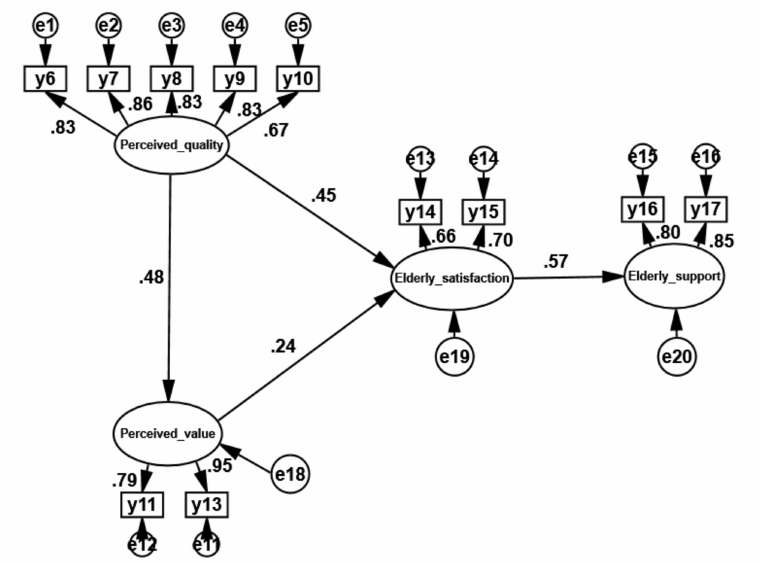
Figure 5. Modified path coefficients of the elderly satisfaction model of nursing